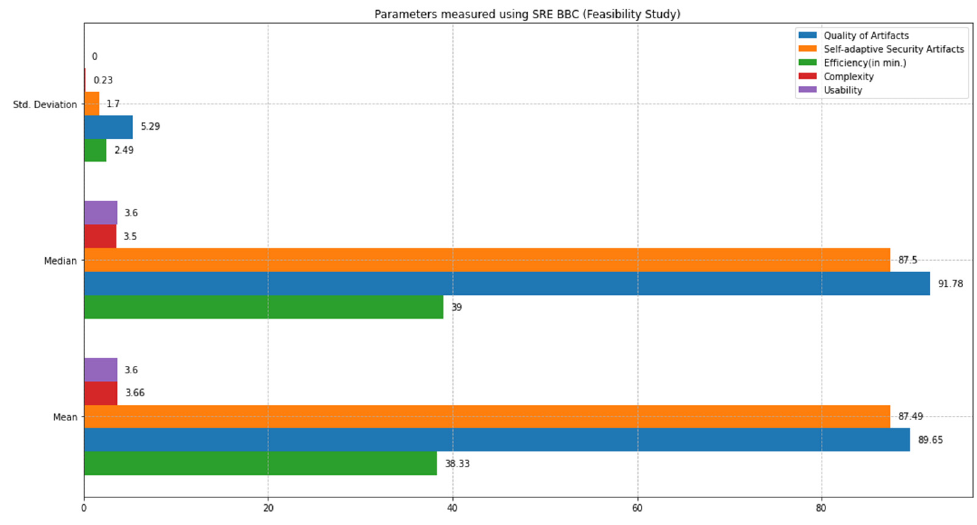
Figure 13. Statistical test for parameters measured using SRE_BBC approach for feasibility study.